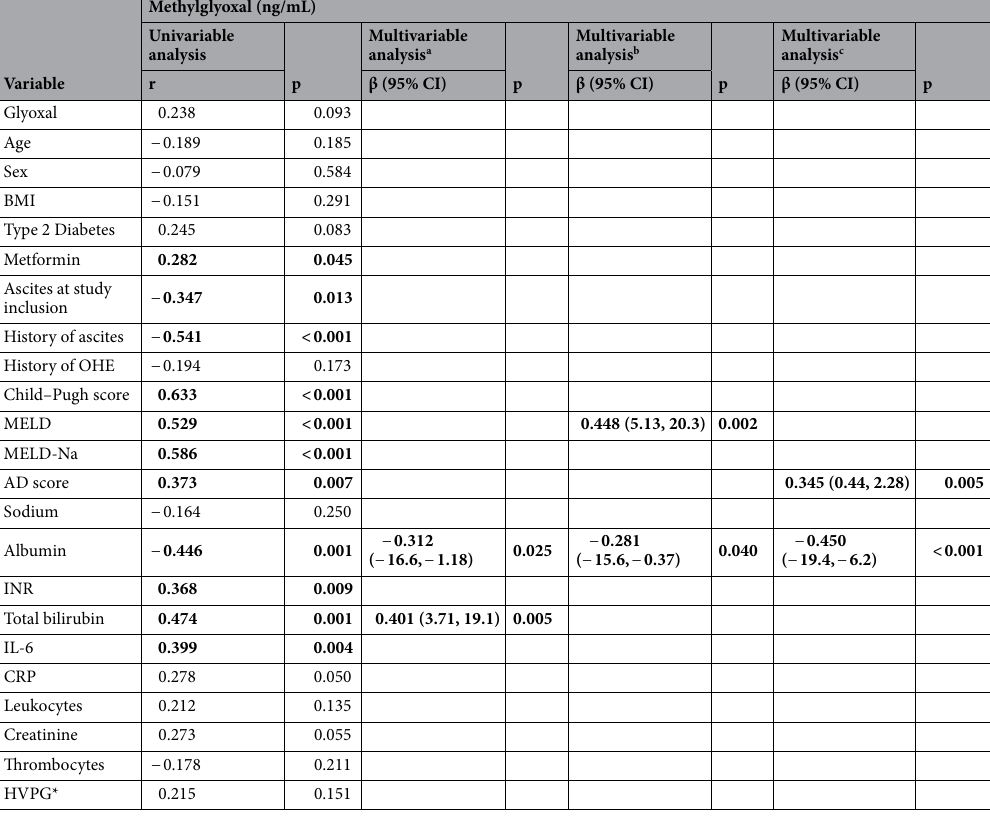
Table 2. Univariable and multivariable analyses for predictors of higher methylglyoxal levels in patients with liver cirrhosis. AD acute decompensation, BMI body mass index, CRP C-reactive protein, OHE overt hepatic encephalopathy, IL-6 interleukin-6, INR international normalized ratio, HVPG hepatic venous pressure gradient, MELD model for end-stage liver disease, MELD-Na model for end-stage liver disease-sodium. Univariable and multivariable analyses of the data are shown. With all factors showing a p value < 0.05 and the clinical parameters age, sex and type 2 diabetes, a multivariable linear regression model was built. Beta (β) and 95% confidence intervals (CIs) show standardized values. Boldface indicates significance. A p value < 0.05 was considered significant. *Measured in 46 patients. a Linear regression analysis: Age, sex, type 2 diabetes, metformin, ascites at study inclusion, history of ascites, albumin, INR, bilirubin, IL-6. b Linear